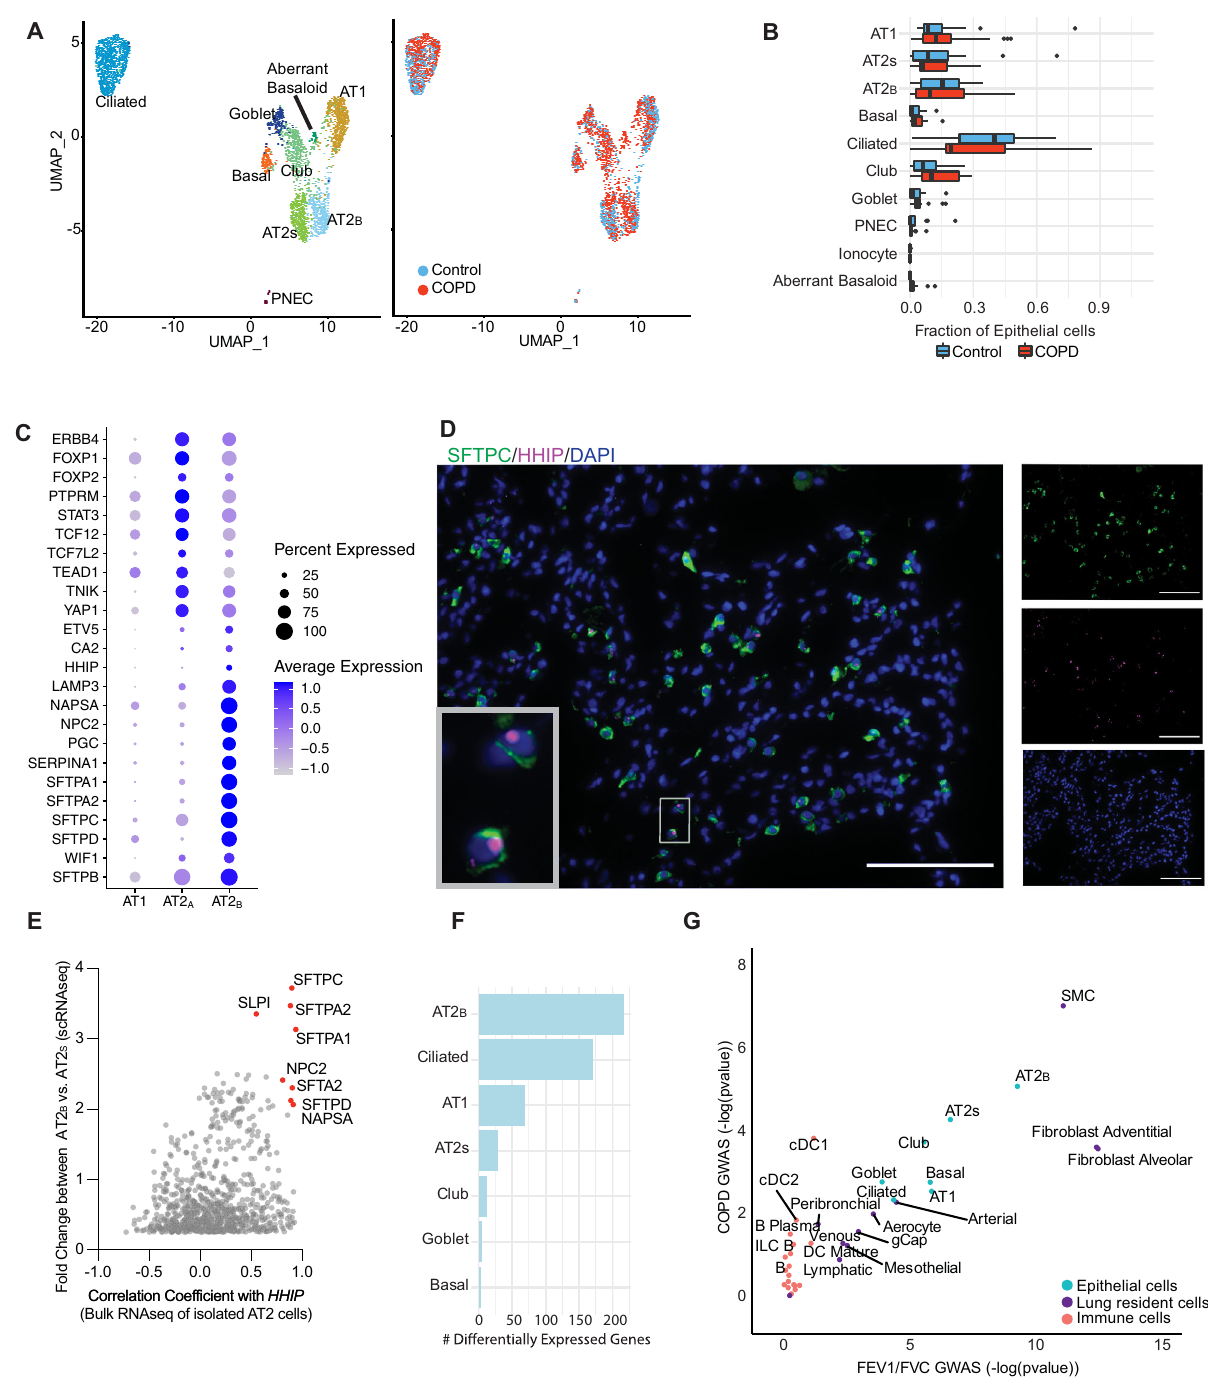
Fig. 2 COPD epithelial cells and the importance of AT2 B cells in COPD pathogenesis. A UMAP of epithelial cells from COPD and control donor lungs.